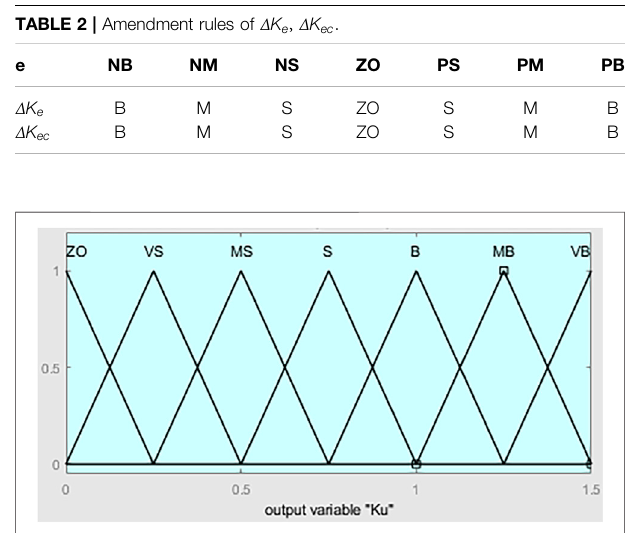
FIGURE 9 | Degree of membership function of Δ K u